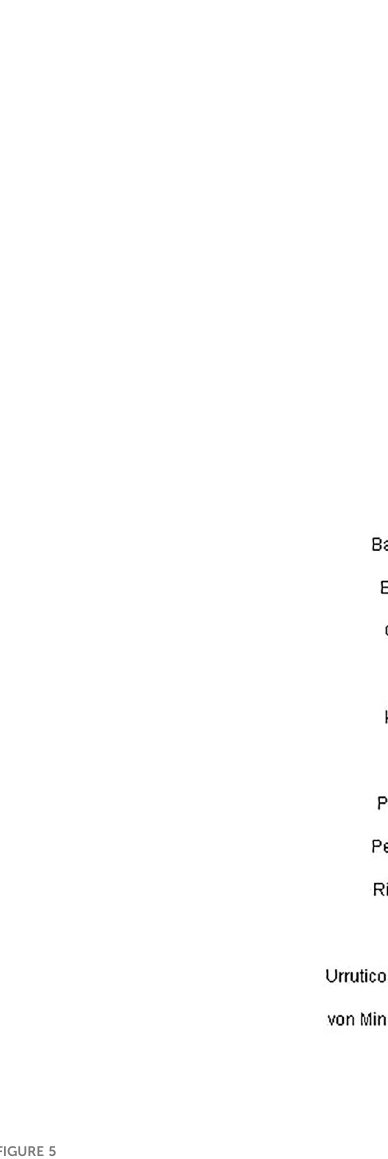
FIGURE 5 Risk of bias